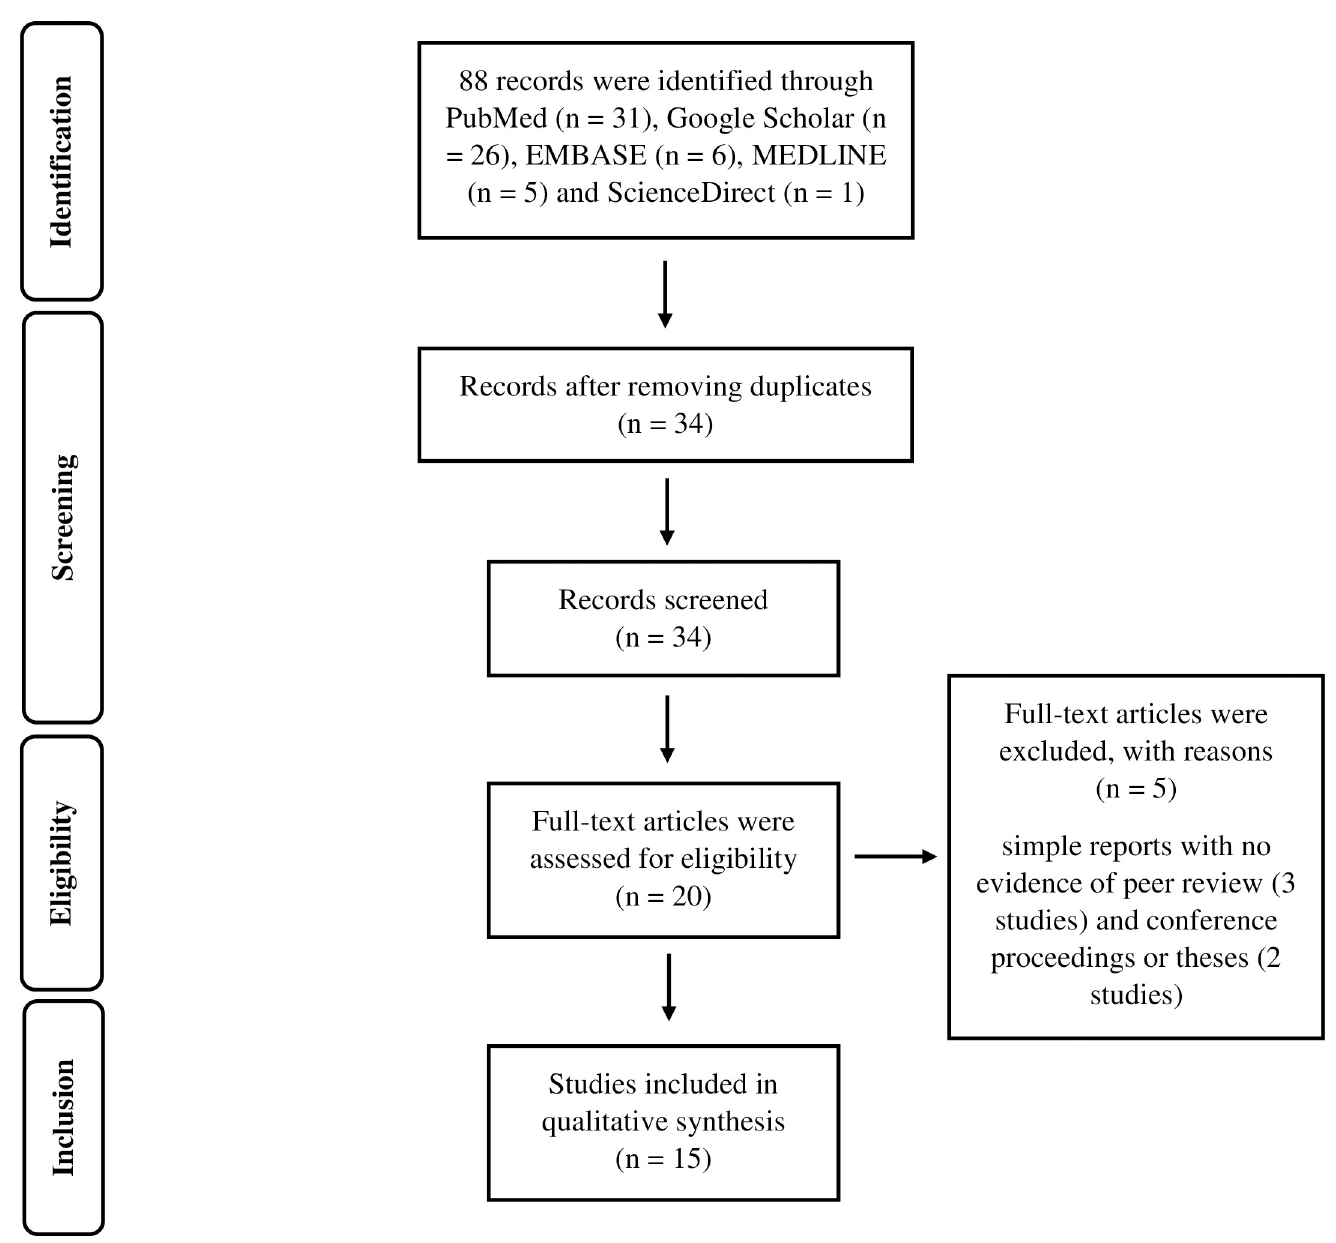
Fig 1. PRISMA flowchart of the literature